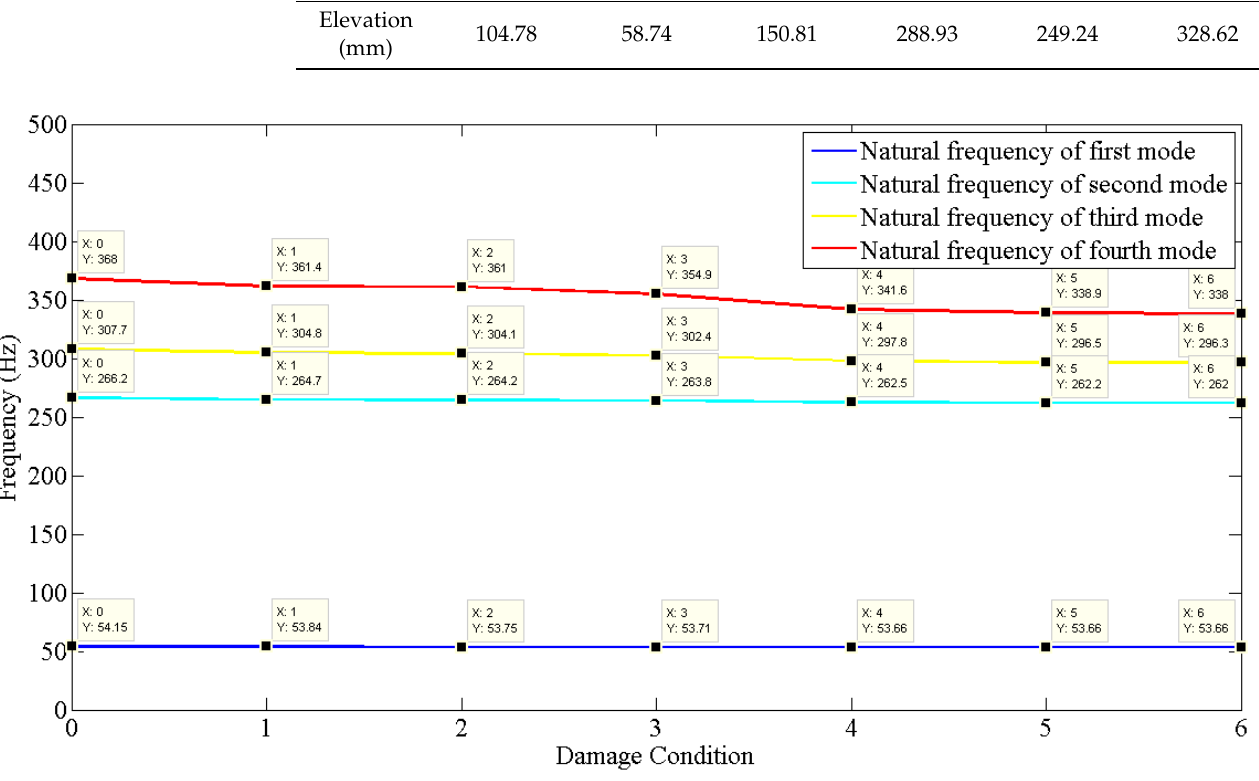
Figure 11. Prediction of structural dynamic behavior of building model under undamaged and dam- aged (Type − 6) conditions through FRFs.